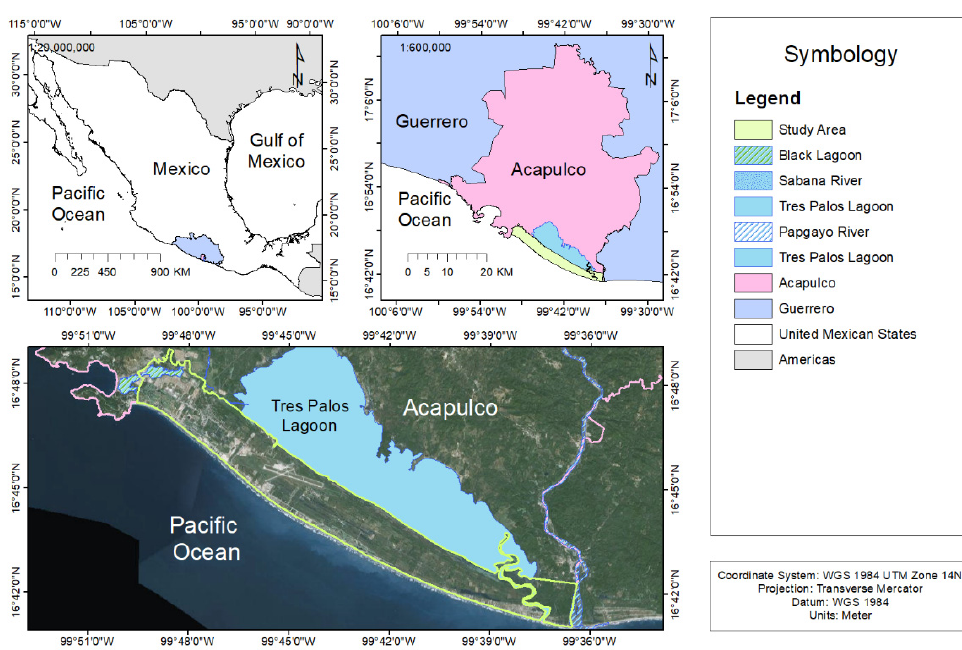
Figure 1. Location of the state of Guerrero in the Mexican Republic (above- left ) and the municipality of Acapulco delimitation of the study area (above- right ), and the limits of the study area in their true colors ( below ). Bands 2, 3, 4 for Landsat 8 (1, 2, and 3 for older